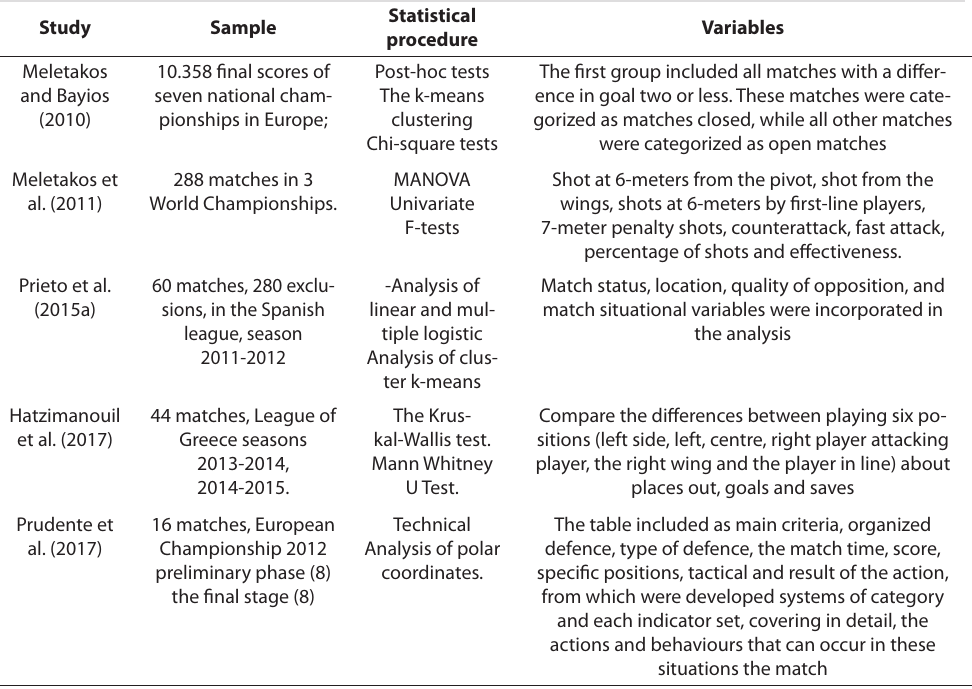
TABLE 5 Empirical studies predominantly with comparative analysis Study